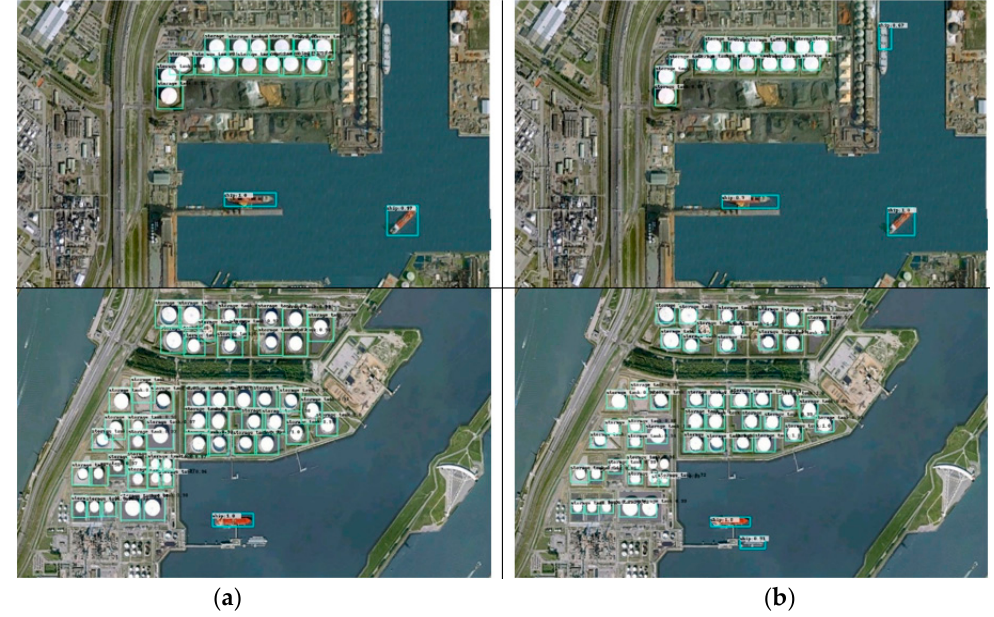
Figure 13. (a) The results of the feature pyramid networks with multi-scale anchor (FPN+MS) experimentation by using three different threshold values of the intersection over union (IoU). The bounding box is larger than its target, which strongly influenced the accuracy of the measurement AP. (b) The detection results of the shallow-deep feature extraction with multi-scale anchor (SD-MS) model for the storage tank class. Each detected bounding box of each target is very close. This has a positive impact on the